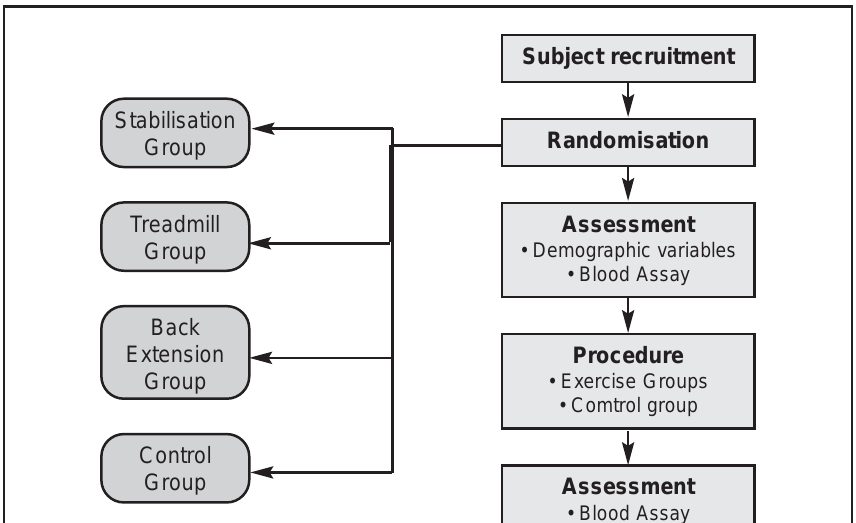
Figure 1: Methodological flow chart